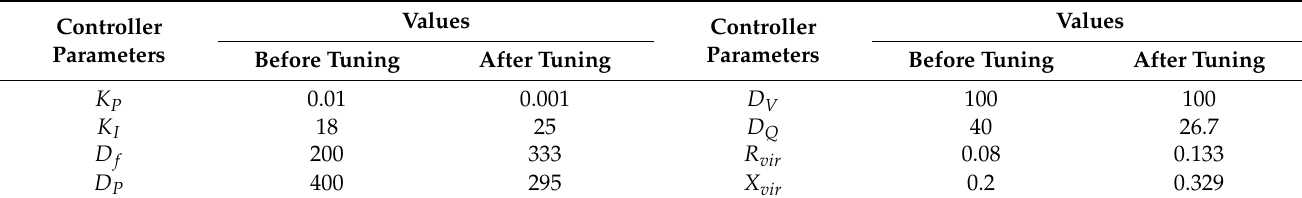
Table 2. Distributed secondary control (DSC) parameters with and without the fuzzy logic controller. Values Controller Controller Parameters Parameters